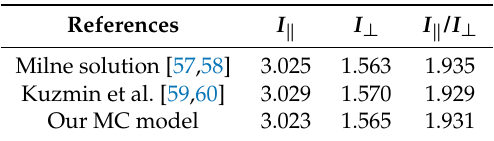
Table 1. A comparison of the results of MC modeling of I (cid:107) and I ⊥ components changing due to scattering with the results obtained with the exact solution by Milne and the results of alternative modeling